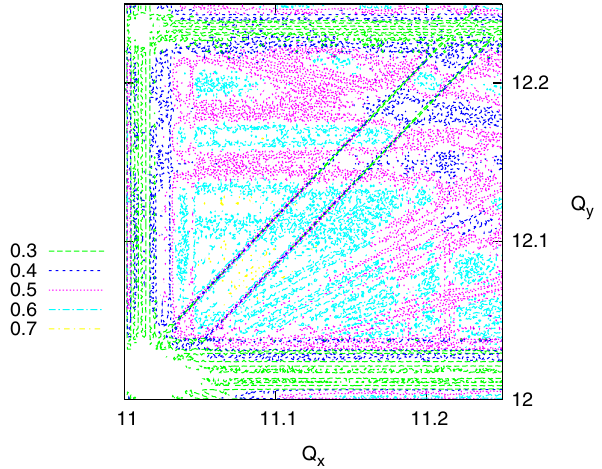
FIG. 8. (Color) Maximum normalized luminosity obtained dur- ing tune scans as a function of the relative beam offset (cid:10)x=(cid:6) x ¼ (cid:10) =(cid:6) y y at the electron lens.